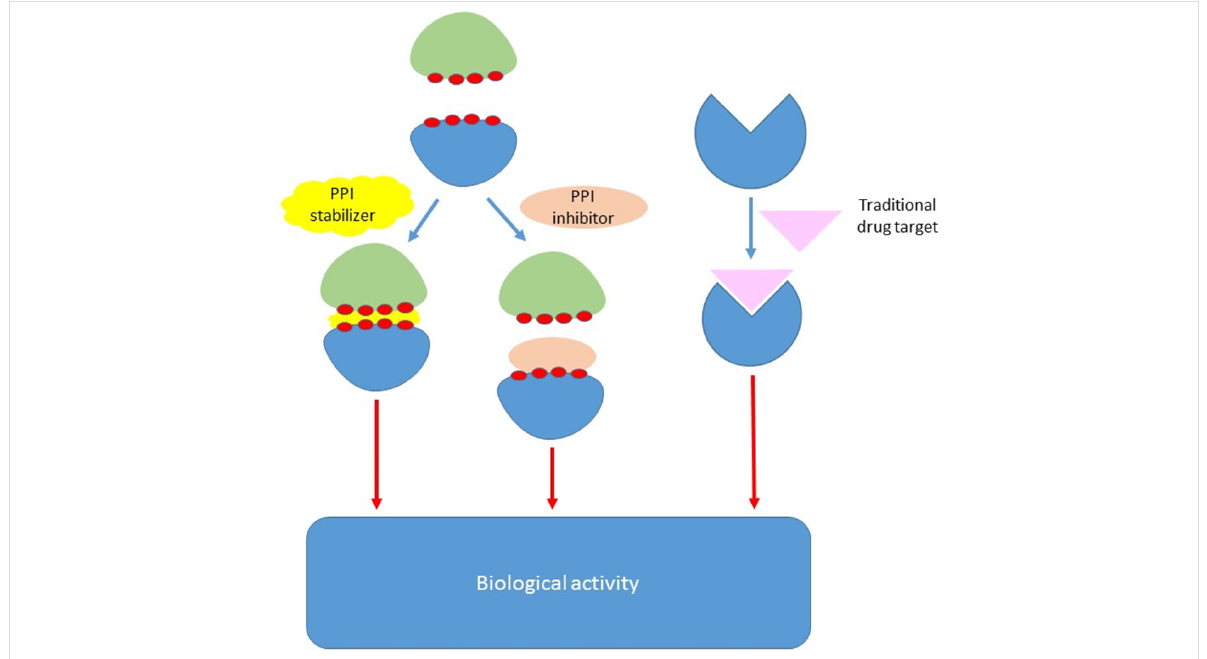
Figure 1: Illustration of a PPI modulator (stabilizer or inhibitor) vs a traditional drug target.